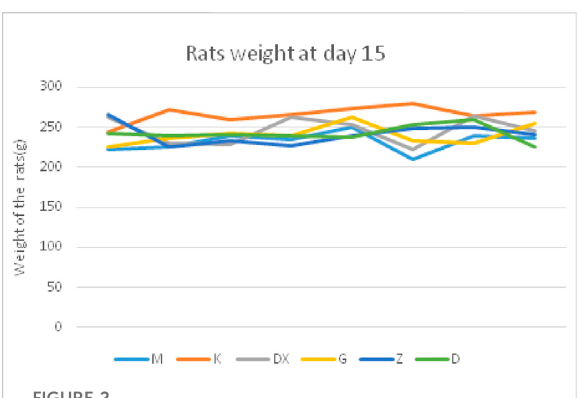
FIGURE 2 Body weight curve in different groups of rats at the 15th